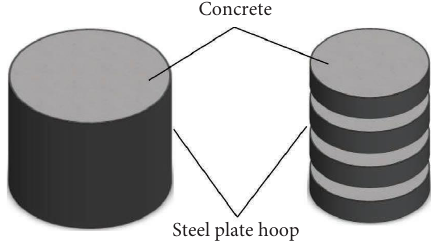
Figure 1: Structural drawing of a common concrete target.